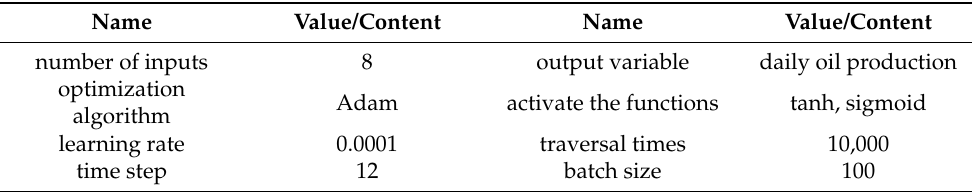
Table 3. Information about the optimal structure of